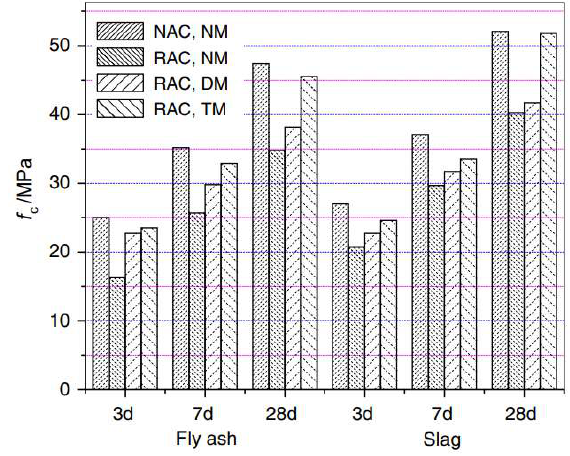
Figure 17. Compressive strength of RCA for different mixing methods [44]. Reproduced with permission from [44], Elsevier, 2010.